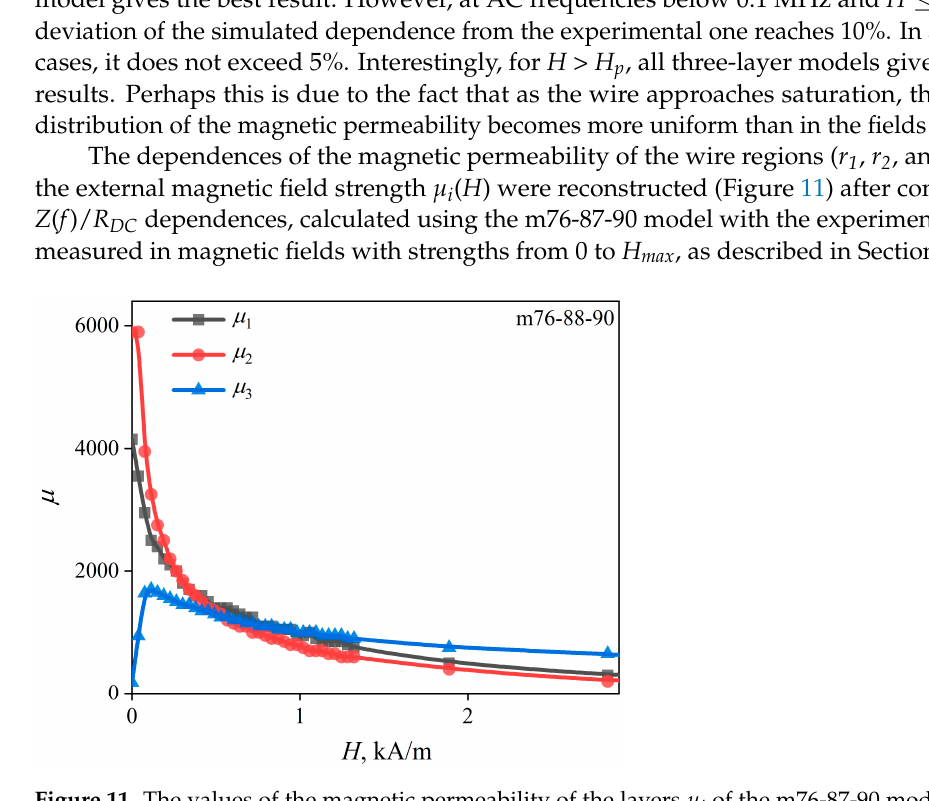
Figure 11. The values of the magnetic permeability of the layers µ i of the m76-87-90 model, corre- sponding to different intensities of the external magnetic field H .